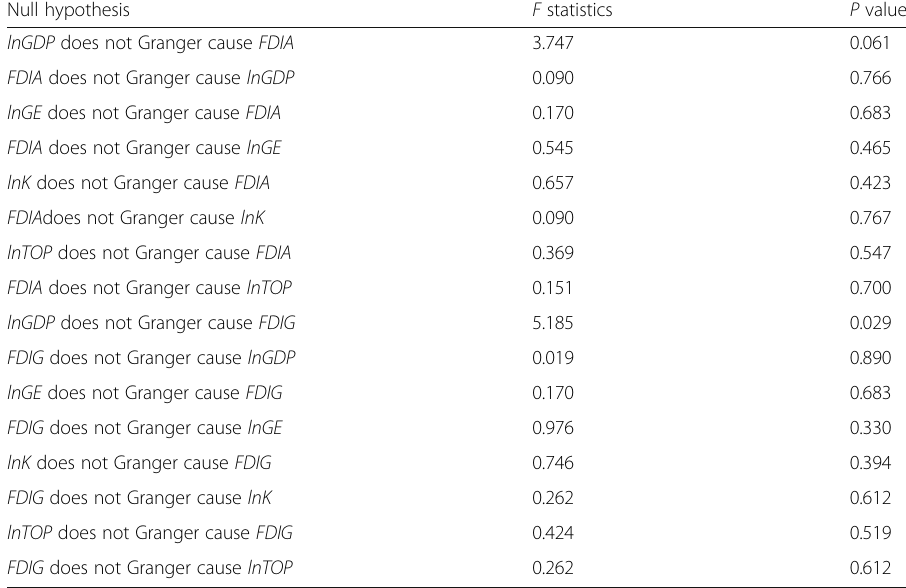
Table 5 Bivariate Granger causality test